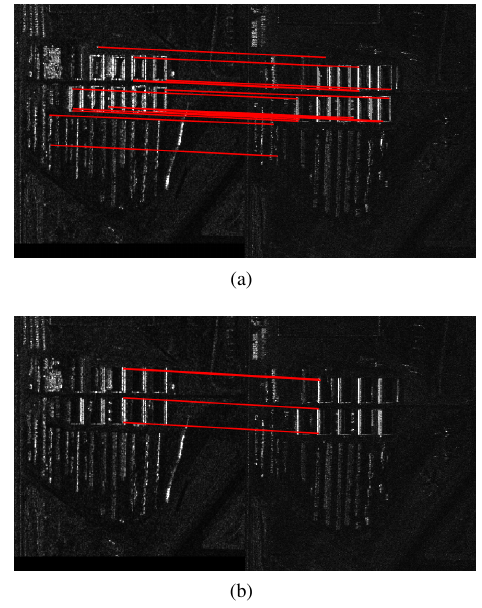
Figure 4. The matching results. (a) Our proposed method (b) The original